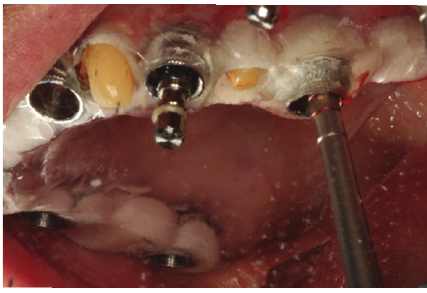
Figure 6: Internal sinus lift and implant osteotomy prepared through the surgical guide for site #